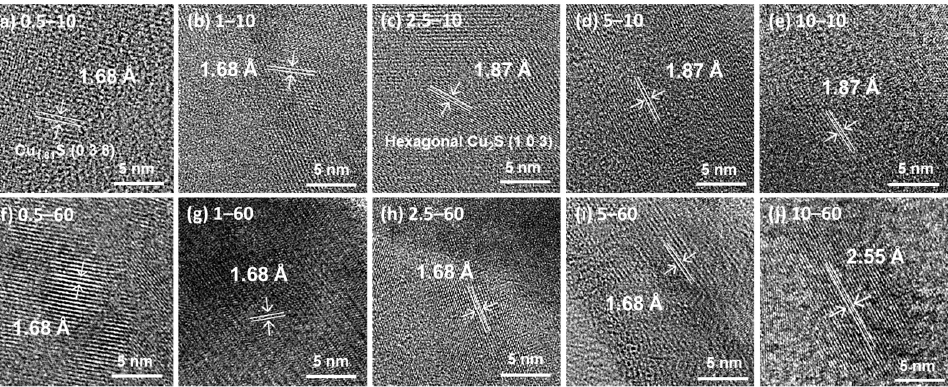
Figure 3. HRTEM images of the samples with varying Na 2 S concentrations (c = 0.5–10 mM) for the reaction times of 10 and 60 min; ( a ) 0.5–10, ( b ) 1–10, ( c ) 2.5–10, ( d ) 5–10, ( e ) 10–10, ( f ) 0.5– 60, ( g ) 1–60, ( h ) 2.5–60, ( i ) 5–60, and ( j ) 10–60